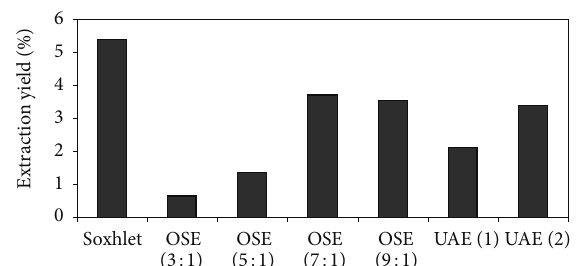
Figure 3: OSE, orbital shaker extraction. UAE, ultrasound-assisted extraction. UAE (1) , continuous ultrasound-assisted extraction for 3 h. UAE (2) , ultrasound-assisted extraction with intervals. out at the maximum temperature possible (i.e., boiling point room temperature.